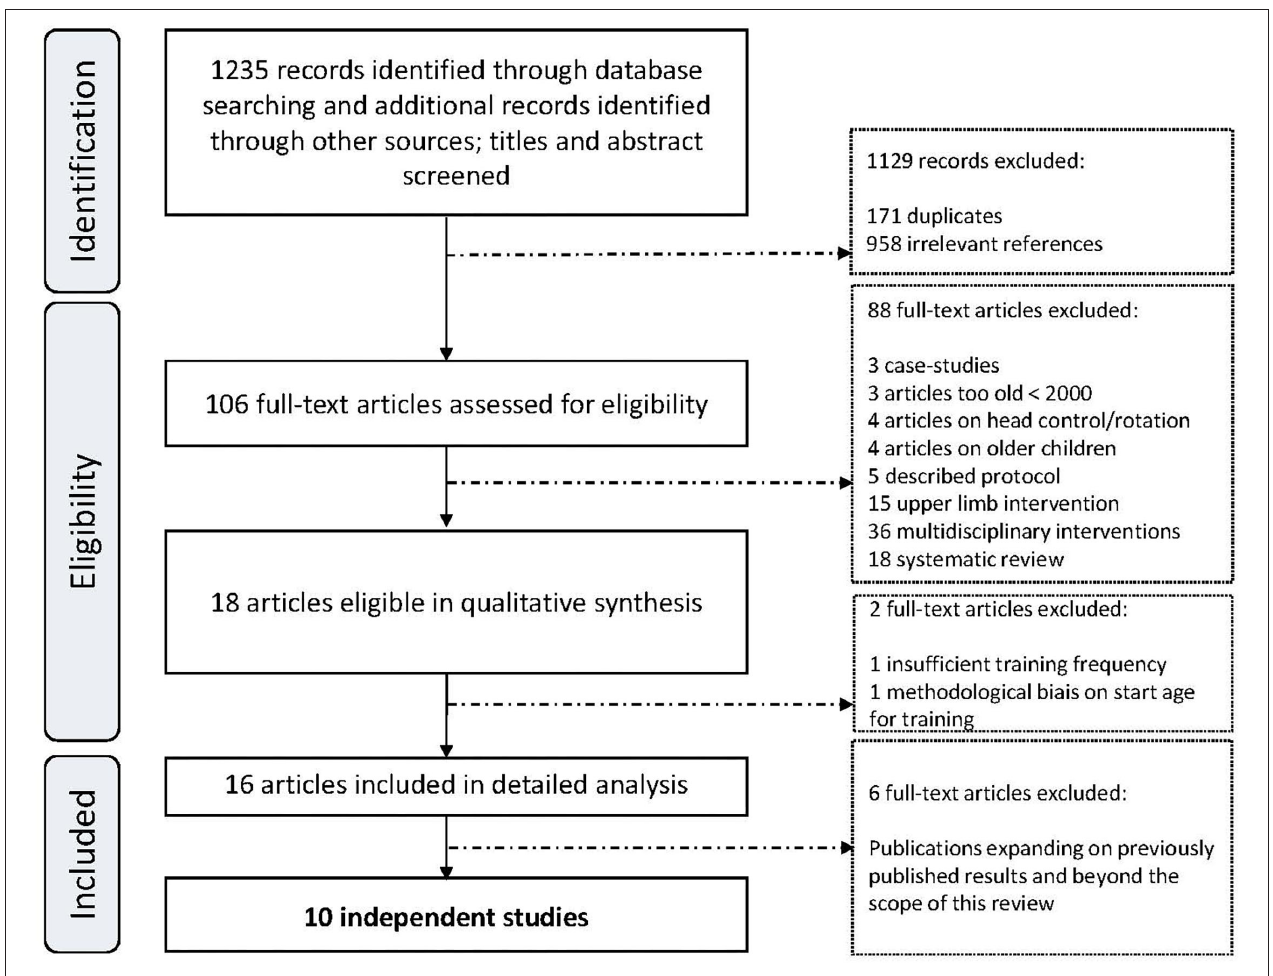
FIGURE 1 | Search strategy and articles